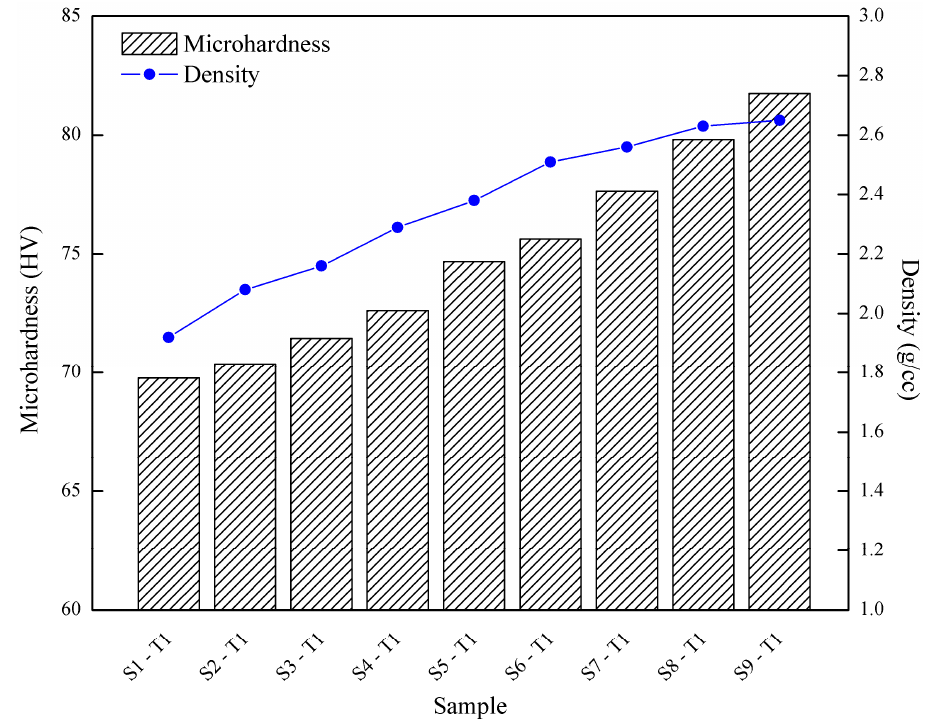
Figure 7. Results of microhardness and density at different operating times and temperatures.